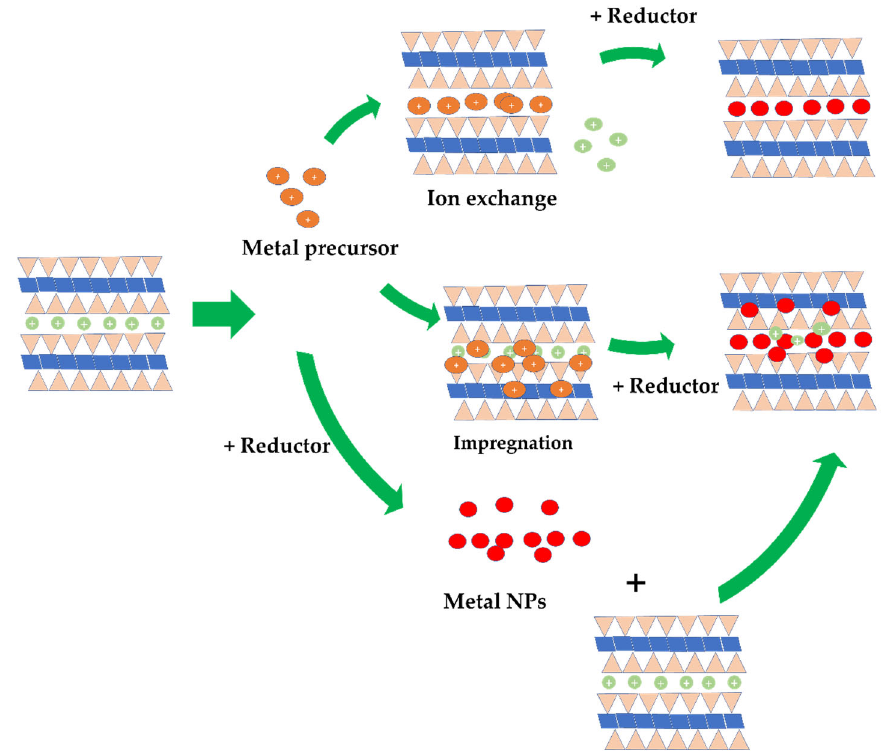
Figure 12. Schematic representation of the dispersion of metal nanoparticles in clay structure.